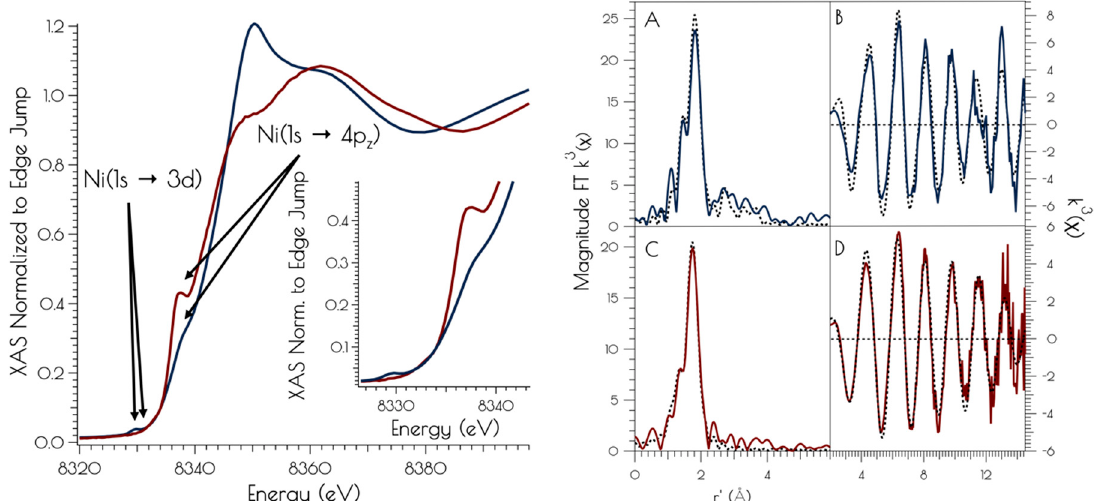
Figure 3. Left: XANES region of the Ni K-edge X-ray absorption spectrum for {Ni 2II (SOD mds )} at pH 7.4 (red) and 9.6 (blue). The inset depicts a blow-up of the Ni(1s → 3d) and Ni(1s → 4p z ) transitions. Right: Magnitude Fourier Transformed k 3 ( χ ) and unfiltered k 3 ( χ ) for {Ni 2II (SOD mds )} at pH 9.6 ( A and B ) and 7.4 ( C and D ). Refinements pH 7.4: (a) Ni–S: n = 2; r = 2.1804(14) Å; σ 2 = 0.0026(2) Å 2 , (b) Ni–N: